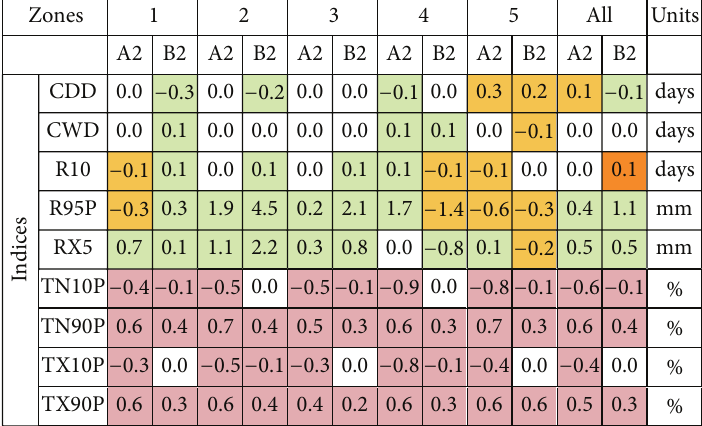
Figure 8: Change in linear trend for 2071–2099 relative to 1961–1989 for all indices across each zone and the entire Caribbean domain for the A2 and B2 scenarios. Trends are calculated using all grid points in the defined zones. Brown (green) cells indicate changes towards drier (wetter) conditions. Red (blue) indicates changes towards hotter (colder) conditions. CDD (CWD) is the maximum number of consecutive dry(wet)days;R10istheannualcountofdayswhenprecipitationisgreaterthanorequalto10 mm;R95Pistheannualtotalprecipitationwhen rainfall is greater than the 95th percentile; RX5 is the annual highest 5-consecutive-day precipitation (mm); TX90 (TN90) is the percentage of days when maximum (minimum) temperature is greater than the 90th percentile; TX10 (TN10) is the percentage of days when maximum (minimum) temperature is less than the 10th